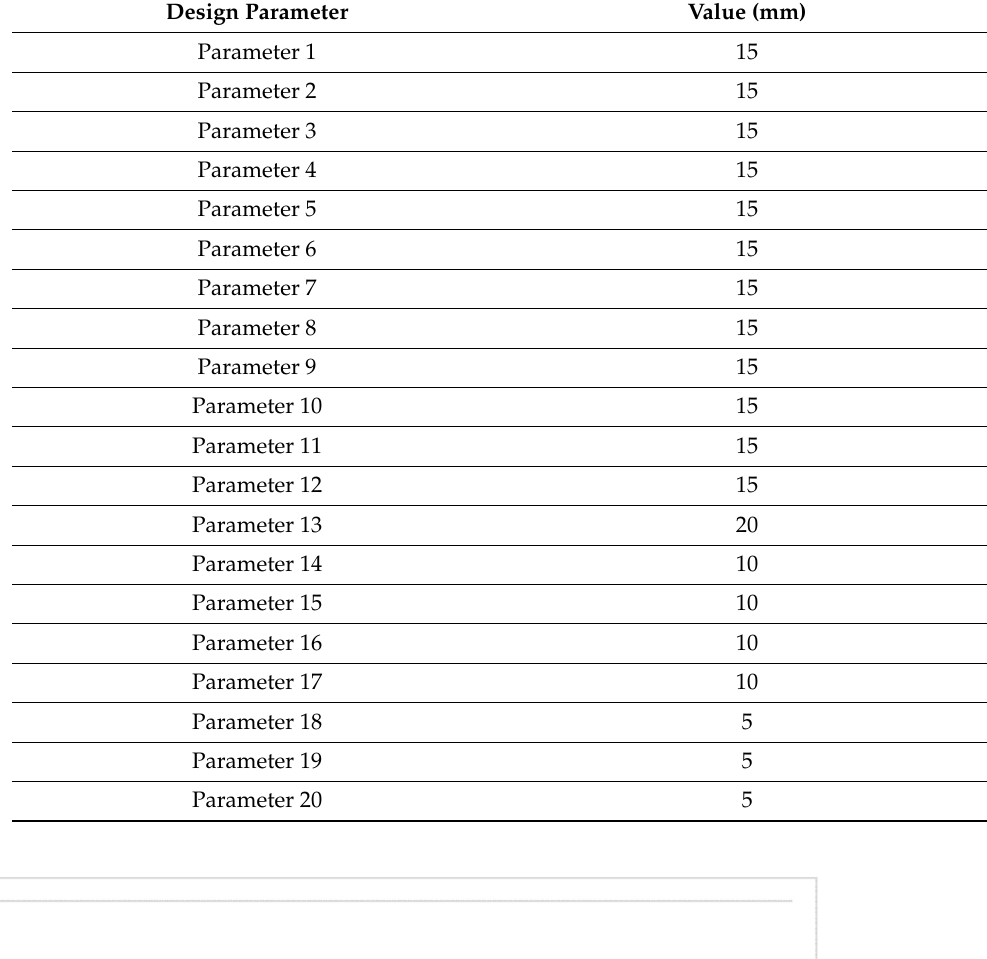
Table 3. Optimal design points.